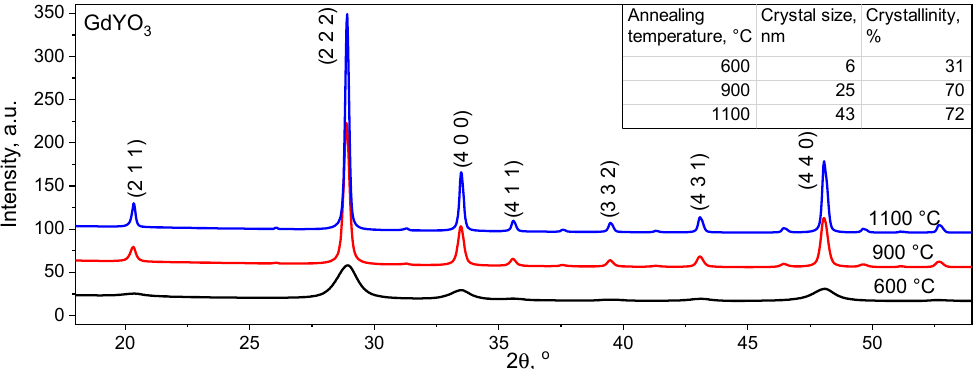
Figure 1. XRD patterns of GdYO 3 powders synthesized at different temperatures (inset: crystal size and crystallinity degree).